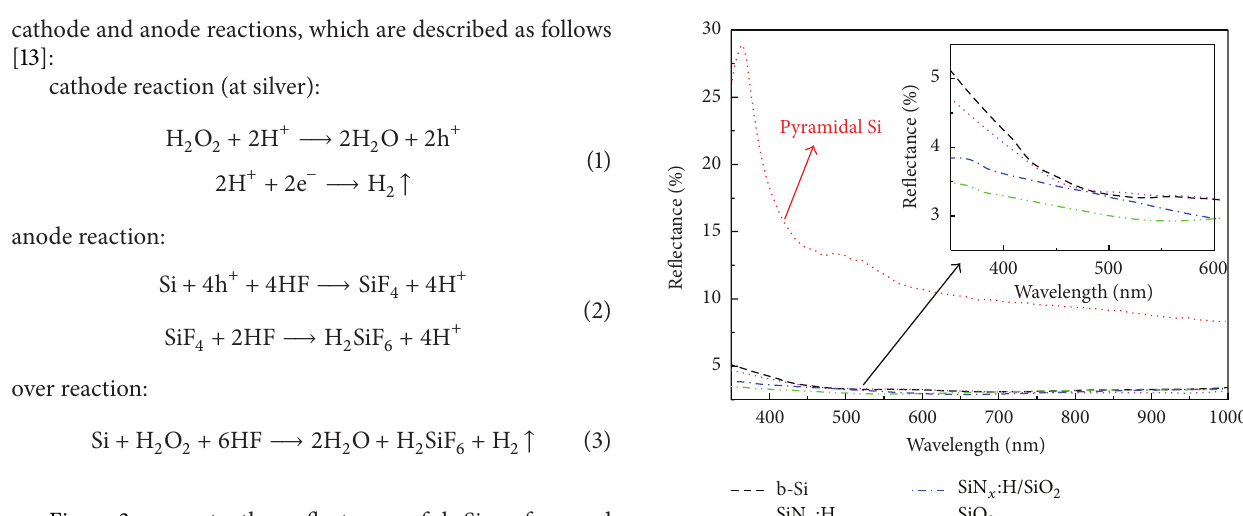
Figure 2: SEM images of top view (a) and cross-sectional view (b) of pyramidal textured Si. SEM images of top view (c) and cross-sectional view (d) of as-etched binary structure textured b-Si.